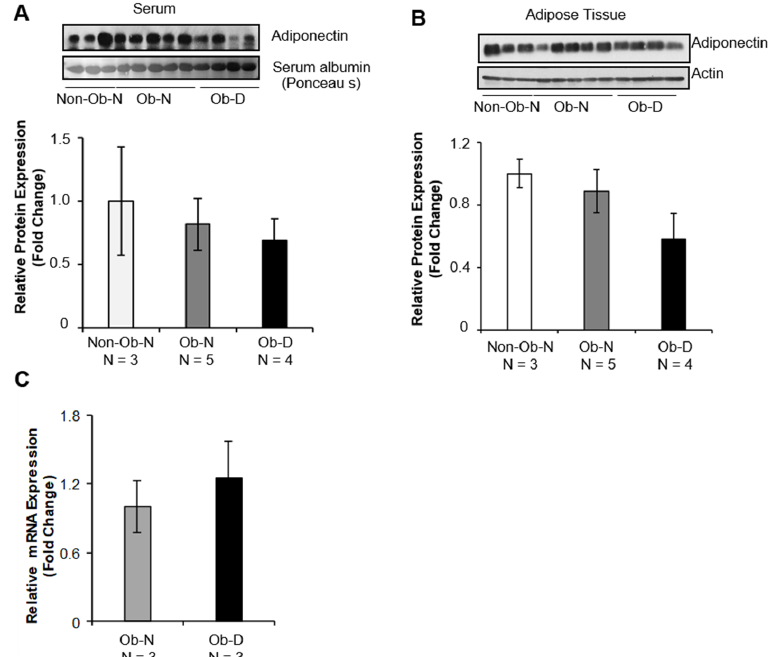
Figure 2. Total adiponectin protein and mRNA levels in non-obese and obese patients. Total adiponectin levels were detected in ( A ) sera and ( B ) adipose tissue from Non-Obese–Normal (Non-Ob–N; n = 3), Obese–Normal (Ob–N; n = 5), and Obese–Delayed (Ob–D; n = 4) patients using SDS-PAGE and Western